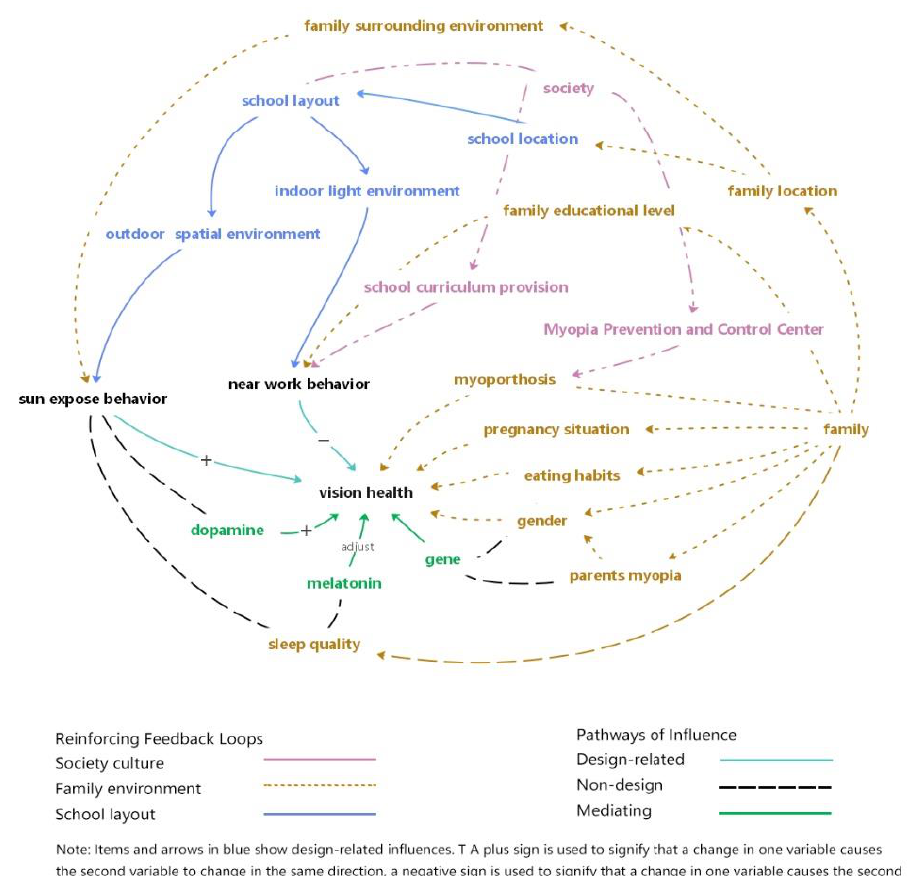
Figure 2. Causal loop diagram of a genetic-environment-behavior system for addressing visual health.